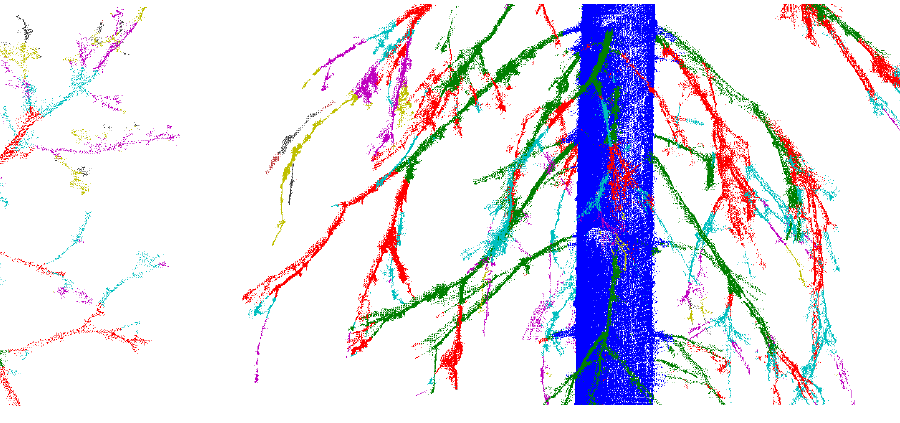
Figure 7. Examples of segmented tree parts. ( Left ) A segmented branch originating from the trunk of an maple. ( Right ) Close-up of a segmented Norway